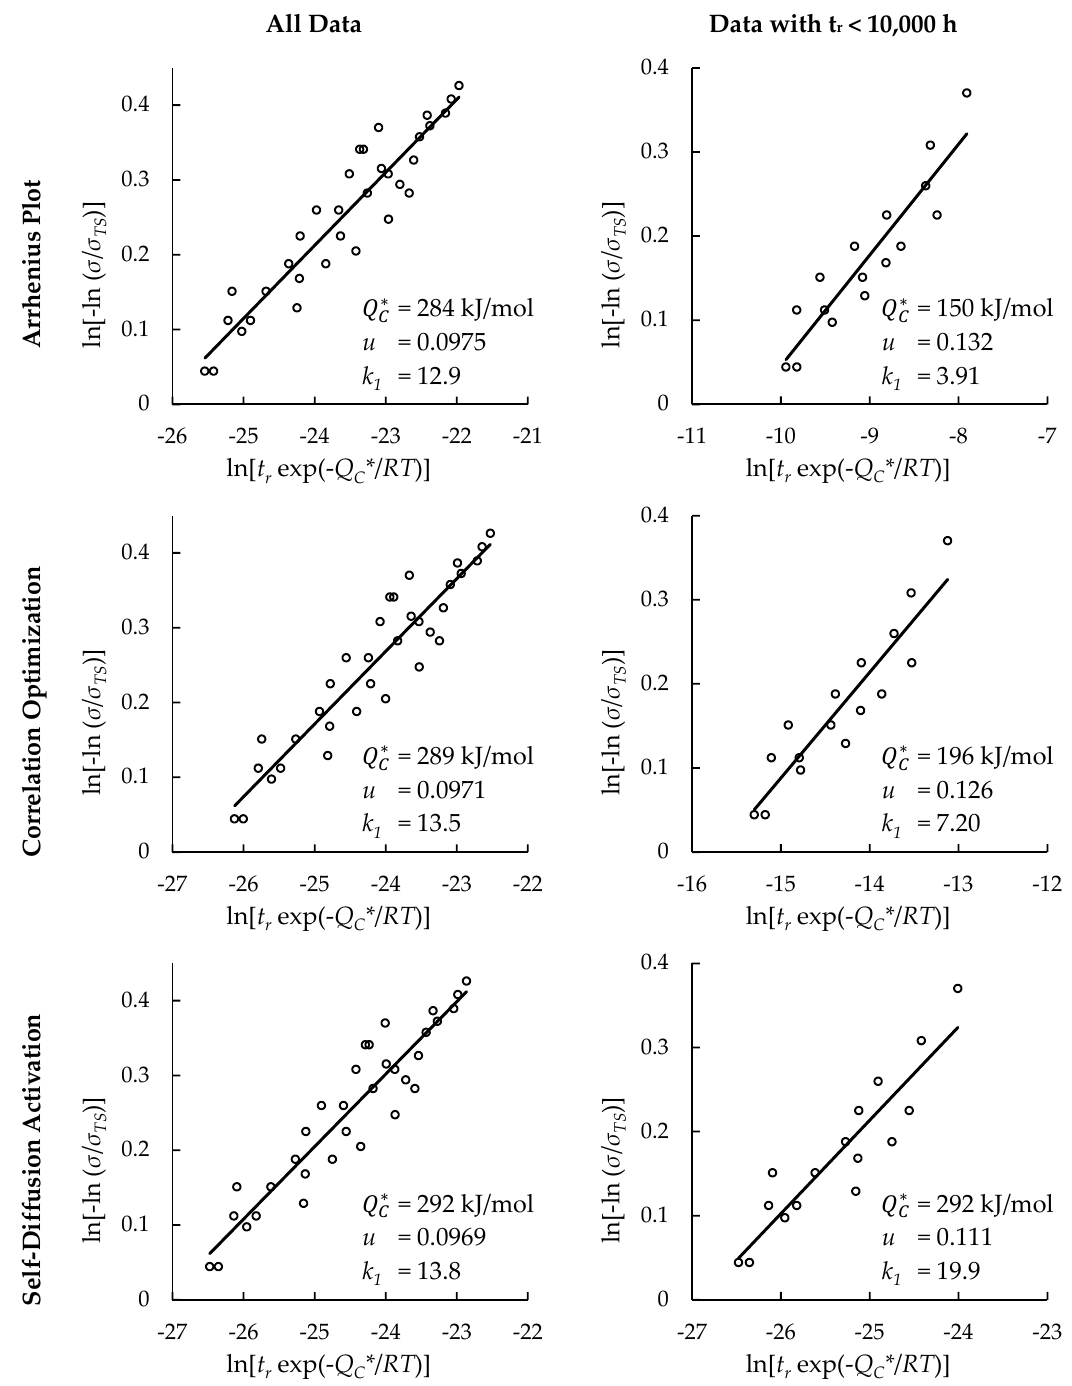
Figure A4. Wilshire plots of Nimonic 105 creep rupture data using average tensile strength values.